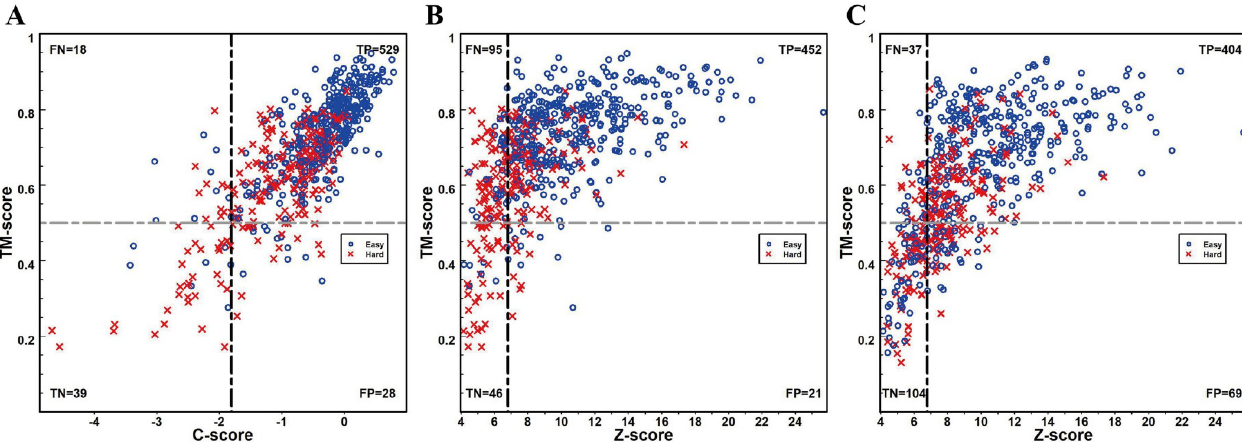
Fig 6. Accuracy estimation of predicted models using different score functions. (A) TM-score of the first C-I-TASSER model versus C-score defined by Eq (8) . (B) TM-score of the first C-I-TASSER model versus CEthreder threading Z-score defined by Eq (7) . (C) TM-score of the first threading template by CEthreader versus the Z-score. Blue circles and red crosses represent Easy and Hard targets respectively. The dashed vertical lines mark the score cutoffs that result in the maximum MCC value for distinguishing models with correct (TM-score > 0.5) and incorrect (TM-score < 0.5) folds, where values given in the sections indicate the number of points in each of the